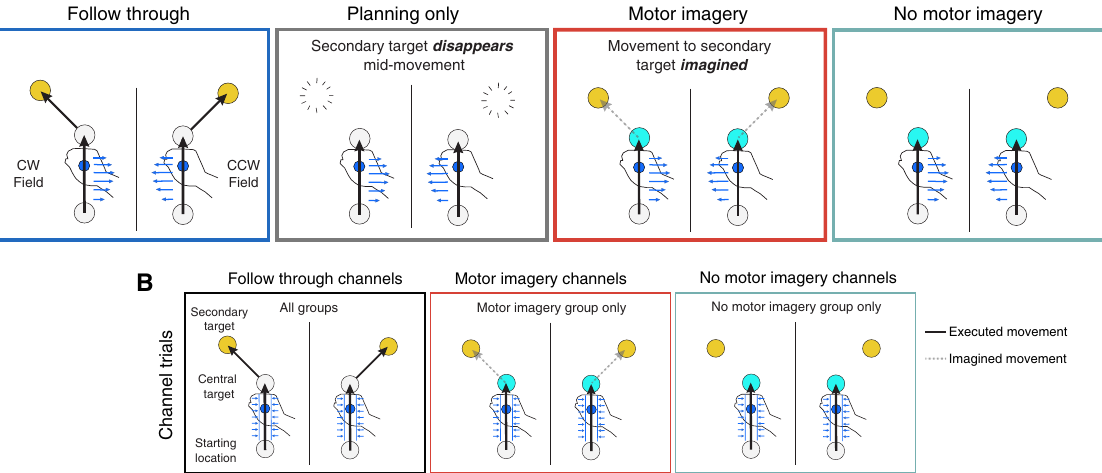
Figure 1. Experimental paradigm. Subjects performed reaching movements that were either ( A ) exposure trials or ( B ) channel trials. On all trials, a starting location, central target and one secondary target (at either − 45° or + 45° relative to the initial movement direction) were displayed from the start of the trial. ( A ) On exposure trials, a velocity-dependent curl force field (blue arrows) was applied on the initial movement. The field direction, clockwise (CW) or counter-clockwise (CCW) was determined by the secondary target location. The exposure trials varied across the groups. The Follow through group continued the initial movement to the secondary target (null field as in channel trials). For the Planning only group, the secondary target disappeared late in the initial movement and they were required to stop at the central target. Both the Motor imagery and No-motor imagery groups were cued by a blue central target, displayed from the start of the trial, indicating that they should stop the movement at the central target. In addition, the motor imagery groups were asked to imagine making a movement to the secondary target and press a button when the imagined movement was complete. ( B ) On follow through channel trials (left), subjects made a movement to the central target followed immediately by a movement to the secondary target. A channel was applied on the initial movement, allowing an assessment of adaptation measured as the forces applied into the channel wall. A null field was applied on the secondary movement. For half of participants in the motor imagery group, we also included channels for imagined follow though trials (middle) at the end of the exposure phase. Likewise, for half of participants in the no-motor imagery group we included channels for movements just to the central target (right). Note that for clarity in all panels the trials for the two different secondary targets are shown separated, but in the experiment the starting and central targets were in identical locations so that the initial movements were the same. In the experiment there were 4 possible starting locations but for clarity we display only